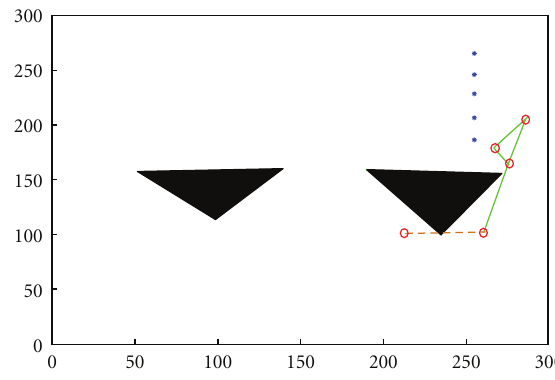
Figure 10: An illustration of a minor constraint violation.